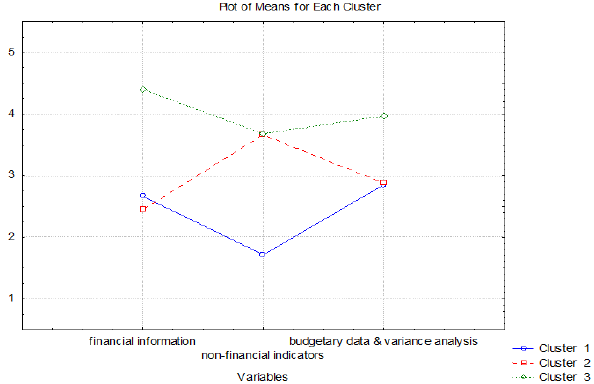
Fig. 7. Object (respondent) grouping with the k-means method in respect of the assessed suitability of selected management accounting information in Poland